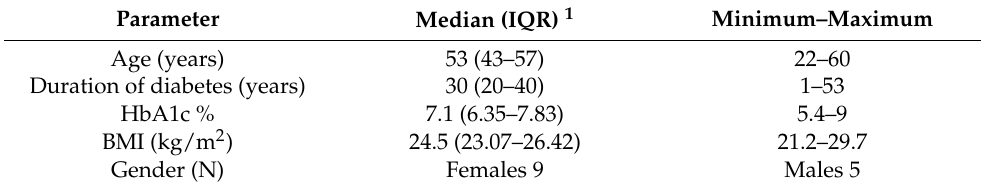
Table 1. Baseline characteristics of participants.